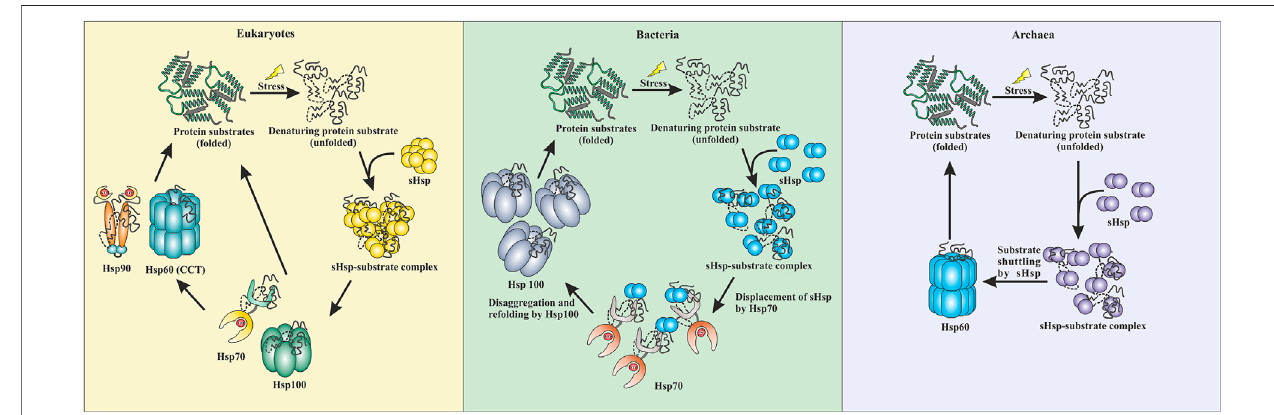
FIGURE 3 | Comparative representation of stress response pathway in three domains of life. In eukaryotes, sHsps bind to the unfolded proteins and prevent aggregation. The unfolded proteins can then be transferred to the Hsp70 pr Hsp100 system. They can refold a protein back to their native conformations. Additionally, Hsp90 can break the deadlock created by Hsp70 and can perform the refolding process. CCT (Hsp60) can also refold a protein back to its native conformation. In bacteria,thesHspsprotectagainst aggregationbybindingtounfoldedproteinswhensubjectedtostress.Hsp70displacesthesHspsandtakesovertherefolding process. Additionally, Hsp100 (disaggregases) comes into the scenario and gets the fi nal refolding complete. Similarly, in archaea, sHsps are the fi rst line of defense. They protect the cell against stress-induced aggregation by binding to unfolded proteins. The unfolded protein substrates are then transferred by sHsps to Hsp60 (thermosome), which performs the fi nal